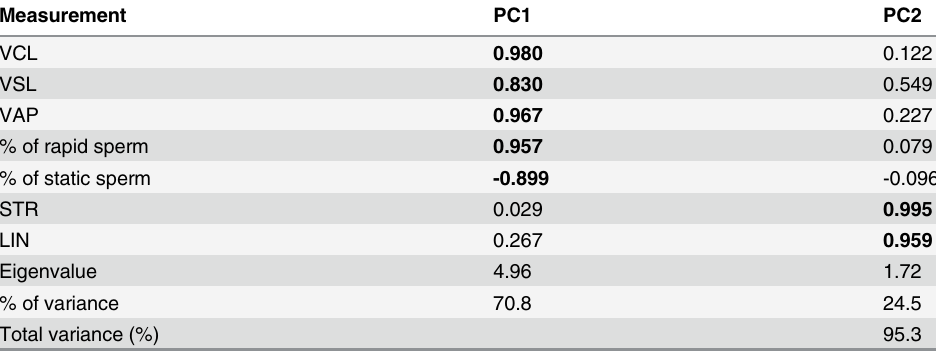
Table 1. Results of Principal Component Analysis (PCA) for measured sperm traits. Measurement